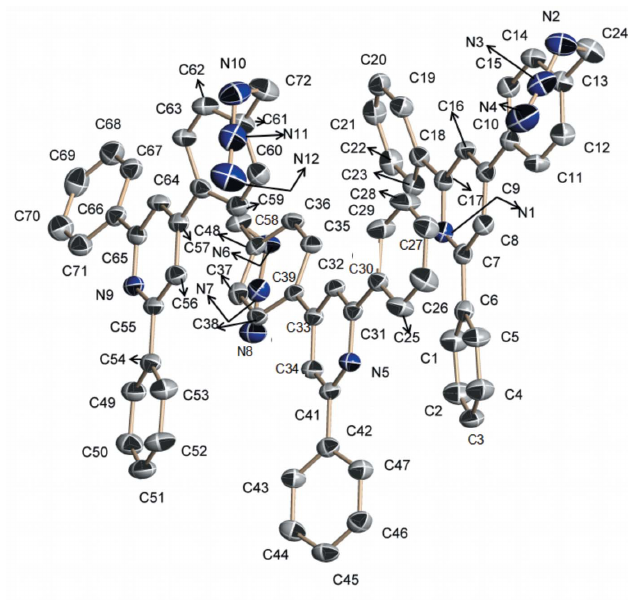
Figure 1 The molecular structure of the title molecule with displacement ellipsoids drawn at the 30% probability level. All H atoms are omitted for clarity.